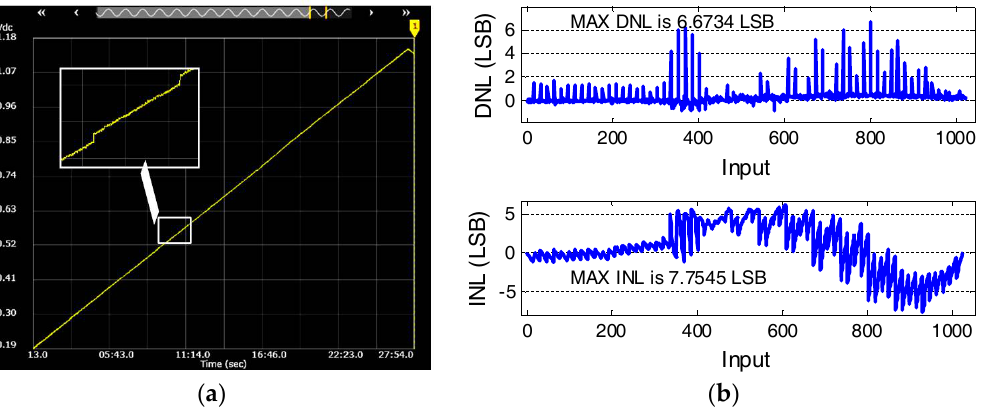
Figure 11. ( a ) The measured output of test group 3 with an input of a full swing triangle wave. ( b ) The static nonlinearity DNL/INL of the measured output versus the digital input, a result of Figure 11a. The output voltage noise spectra density is measured by a spectrum analyzer (Rohde&Schwarz-FSV7), as shown in Figure 12 [25].